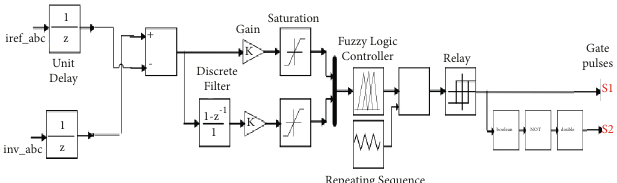
Figure 28: Simulink model of Fuzzy Logic current controller FLCC for PWM Gate Pulse to HAPF.